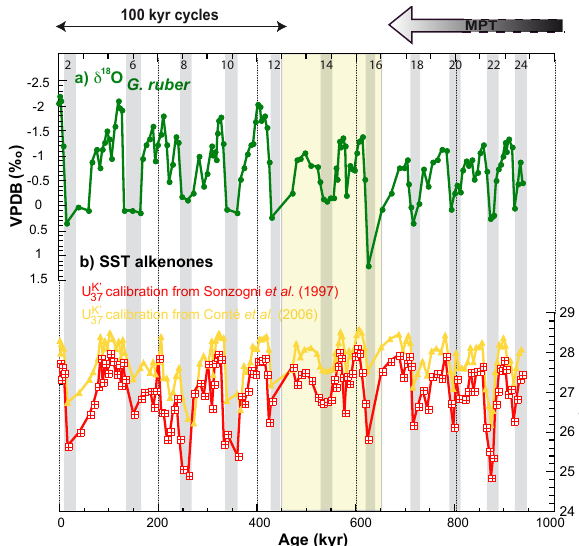
Fig. 4. Core MD03-2628 records for: (a) the δ 18 O of the planktonic foraminifera Globigerinoides ruber (green curve and dots); and (b) sea-surface temperatures as determined by the U K calculated with the Sonzogni et al. (1997) (red curve and squares) and Conte et al. (2006) (yellow curve and triangles) calibrations. Light gray bars and even numbers show the glacial stages as de- fined by δ 18 O. The yellow area indicates the 650 to 450ka time interval, when the duration and shape of the climate cycles changed (see text for